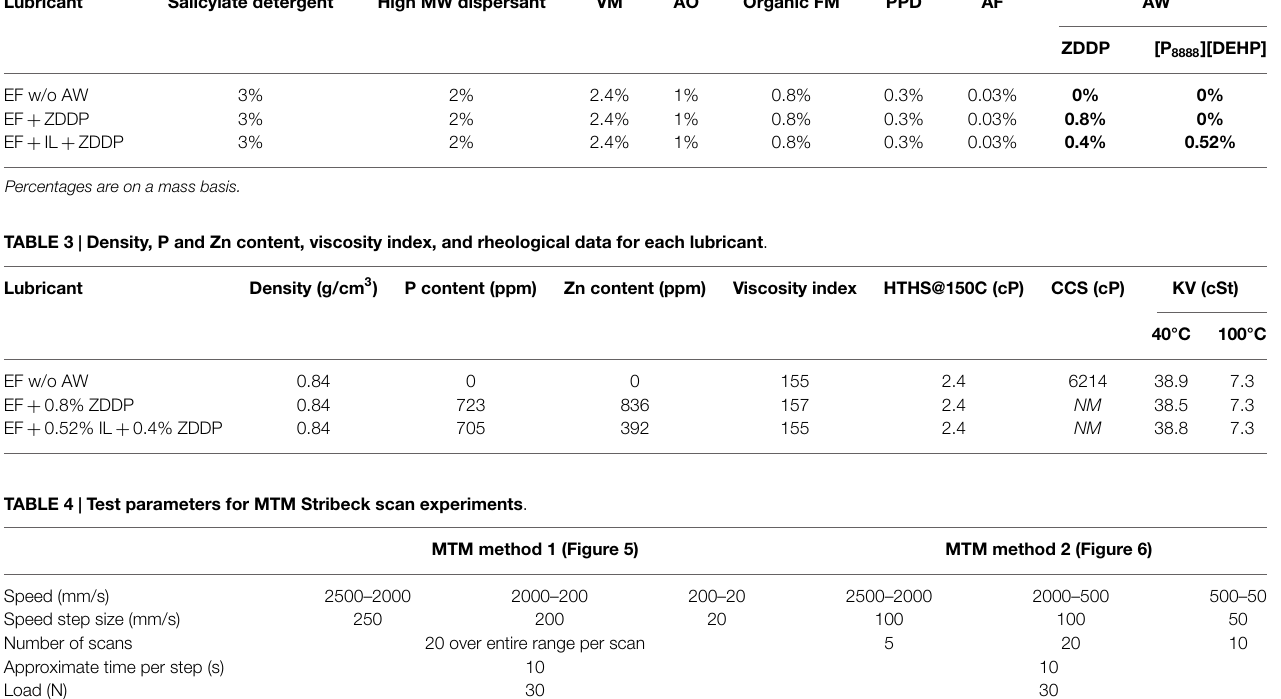
TABLE 2 | Additive composition of each lubricant . Lubricant